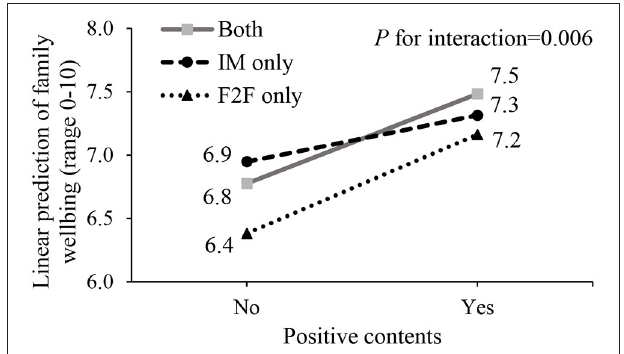
FIGURE 1 | The linear prediction of family wellbeing by communication methods and positive contents a . a IM, Instant messaging; F2F, Face-to-face.